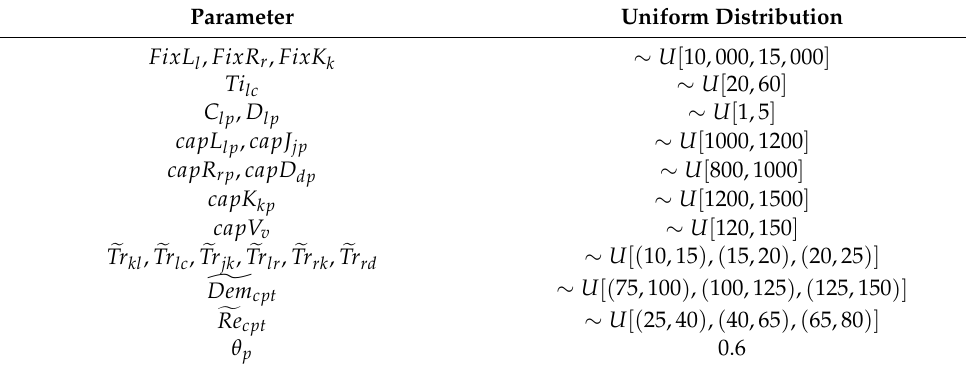
Table 3. Range of definite and indefinite parameters of the problem based on the uniform distribu- tion function. Parameter Uniform Distribution